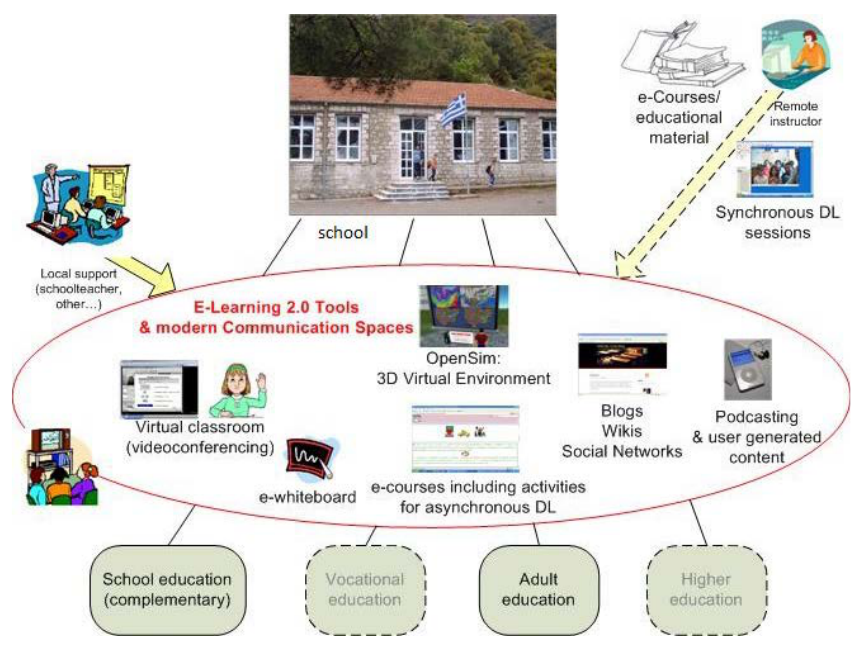
Figure 3. The R EVIT distance learning